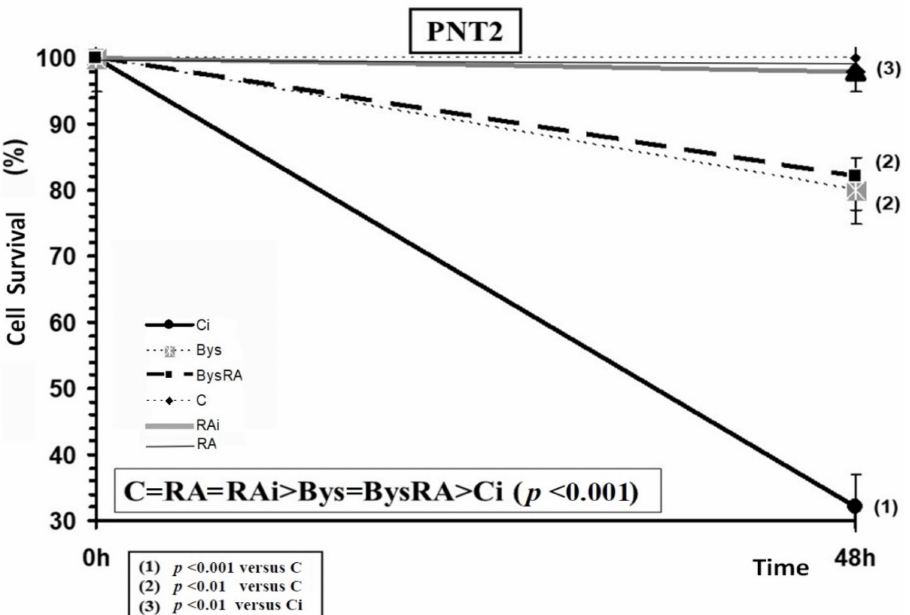
Figure 6. Cell survival of PNT2 cells irradiated to 20 Gy of X-rays after 48 h of incubation (C, control; RA, treated with rosmarinic acid; Ci, irradiated control; RAi, irradiated, previously treated with rosmarinic acid; Bys, treated with the medium of irradiated cell culture; BysRA, treated with the irradiated cell culture medium and with rosmarinic acid). Data are the mean and standard error of eight independent